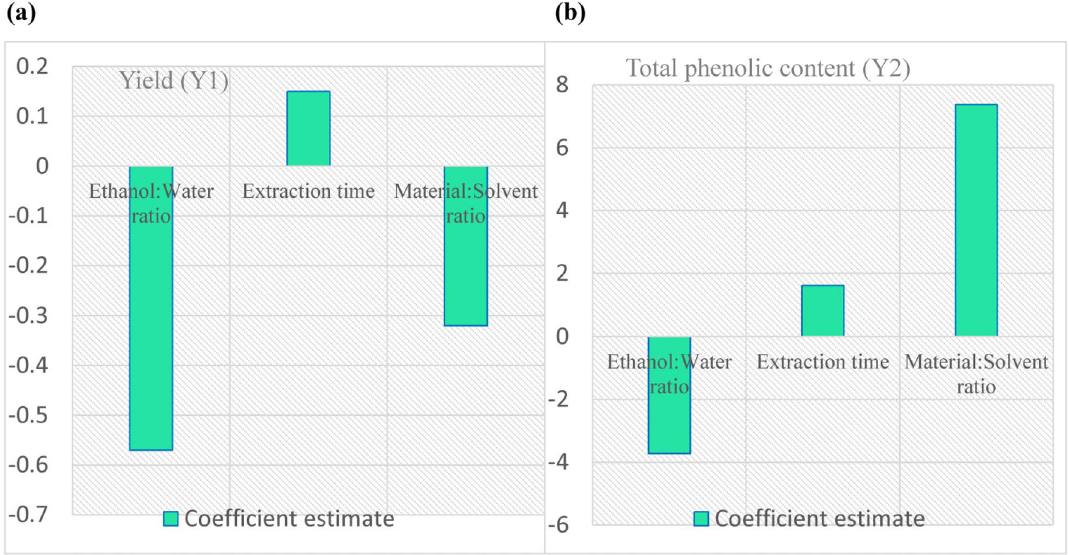
Figure 4. Coefficient estimates of the studied factors for each response. ( a ) Yield ( b ) Phenolic content.